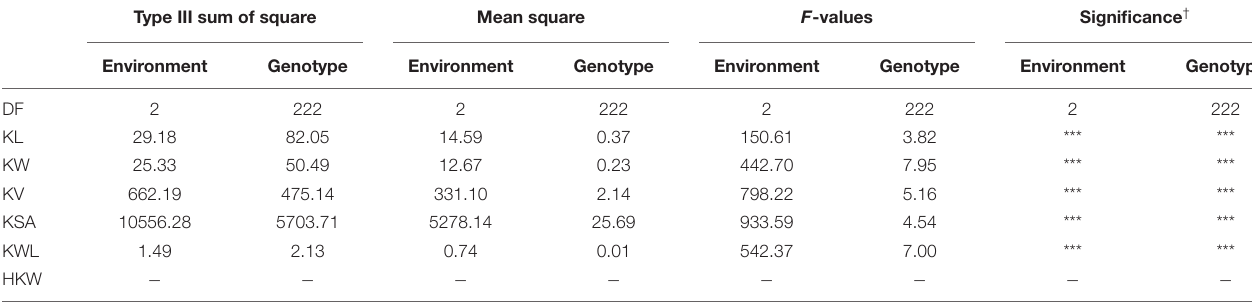
TABLE 1 | The analysis of variance of six kernel traits of 223 Aegilops tauschii among three environments. Type III sum of square Mean square F -values